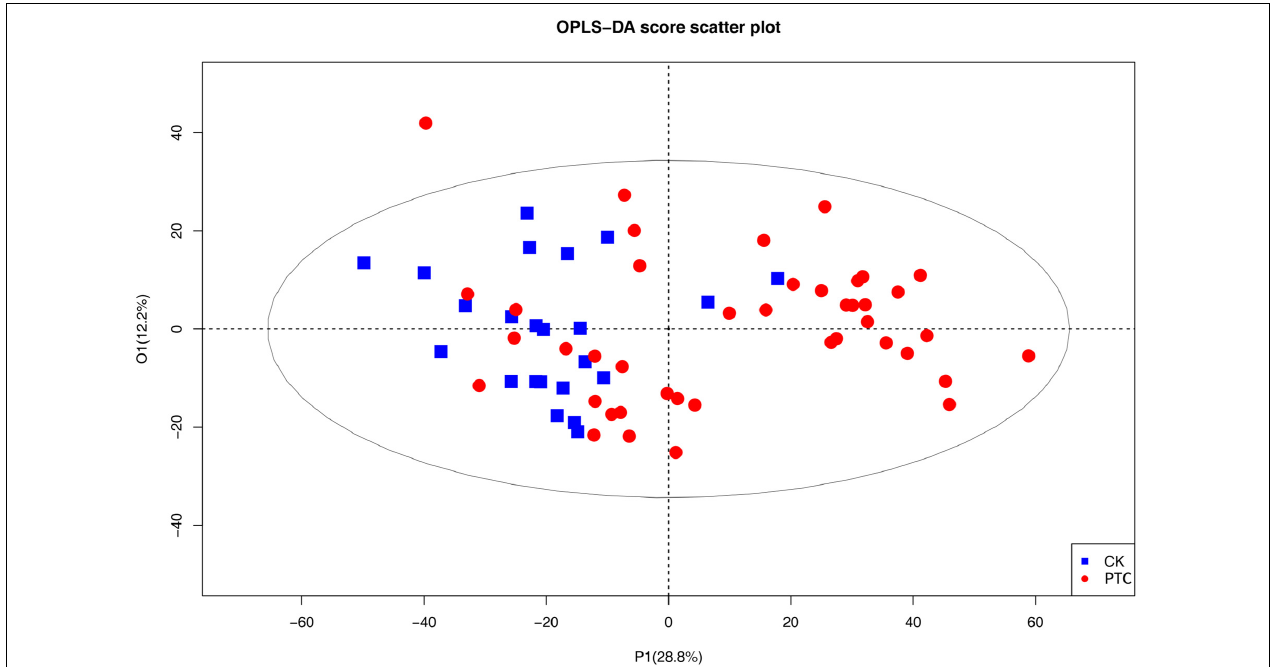
FIGURE 1 | The OPLS-DA score plots based on Q-TOF data sets of metabolites in the plasma of patients with papillary thyroid carcinoma patient and healthy control groups. PTC represents one papillary thyroid carcinoma patient; CK represents one healthy control.